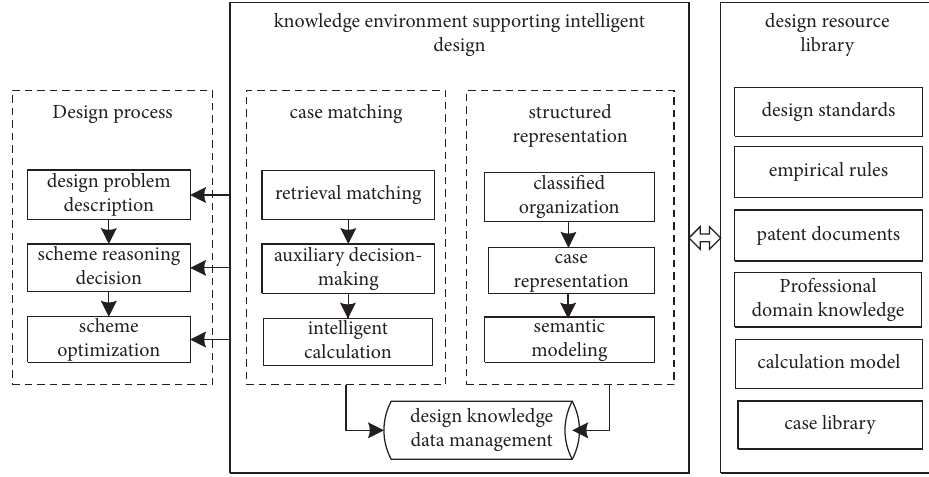
Figure 1: The overview of the intelligent product design knowledge service system.